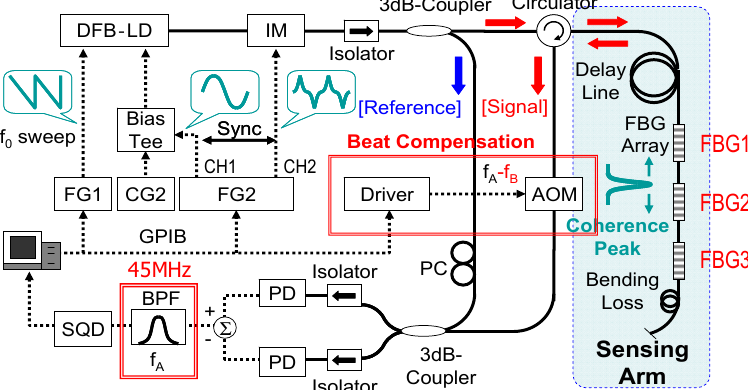
Figure 13. Experimental setup of a quasi-distributed sensing system with multiplexed long-length FBGs by using a synthesized delta function-like optical coherence function [31].